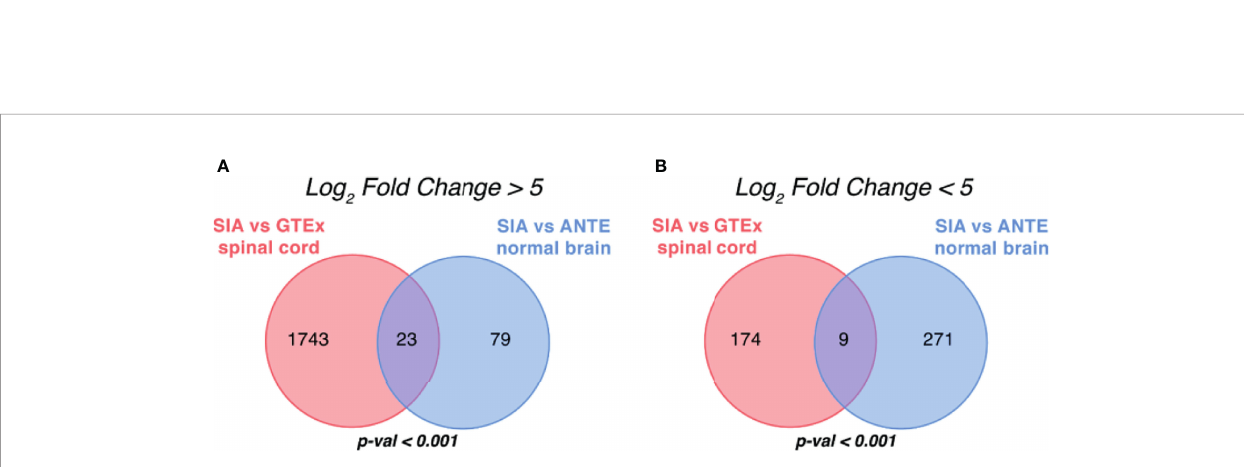
FIGURE 3 | Intersection of differentially expressed gene sets between spinal intramedullary astrocytomas (SIAs), GTEx healthy spinal cord, and ANTE healthy brain samples. Intersections of (A) upregulated and (B) downregulated differentially expressed gene sets between SIA – GTEx spinal cord and SIA – ANTE normal brain samples are shown; p -values for intersection signi fi cance obtained in perturbation test are highlighted in